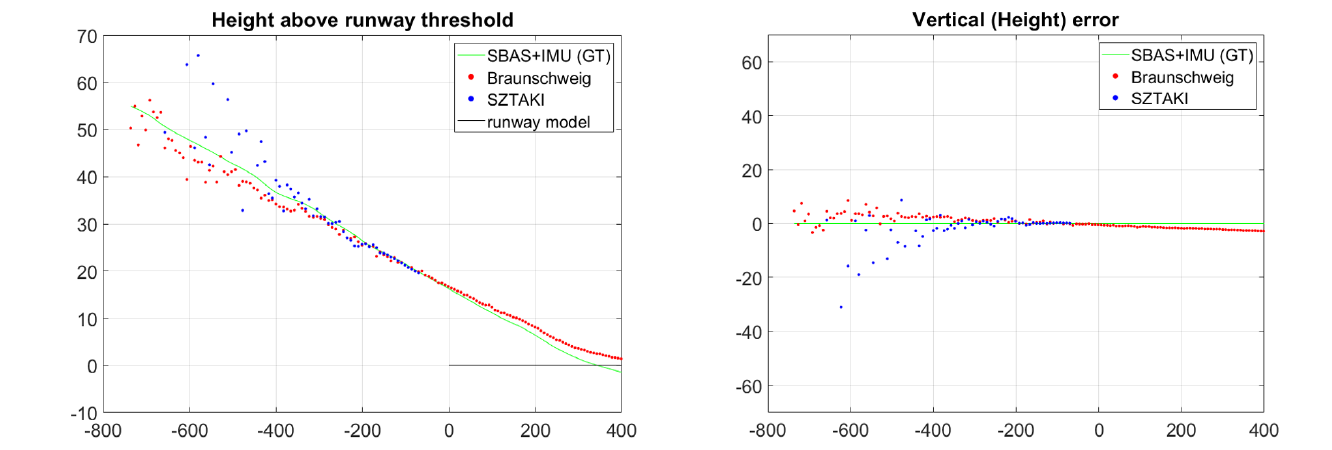
Figure 18. Altitude is the most important navigation data for the aircraft. Braunschweig measurements start at 2000 m with IR-based detections. The SZTAKI sensor first detection is at 718 m and become fully continuous from 434 m. The sign of vertical error is defined by the downward looking Y R axis of the runway frame.